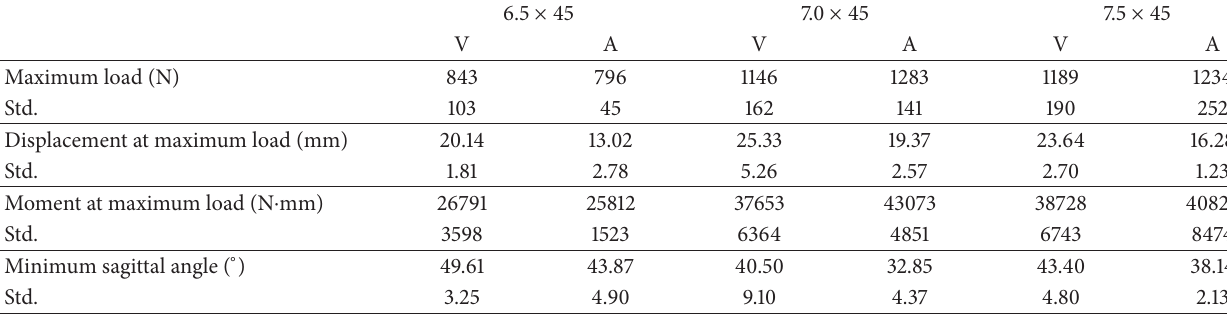
Table 3: Flexion moment test